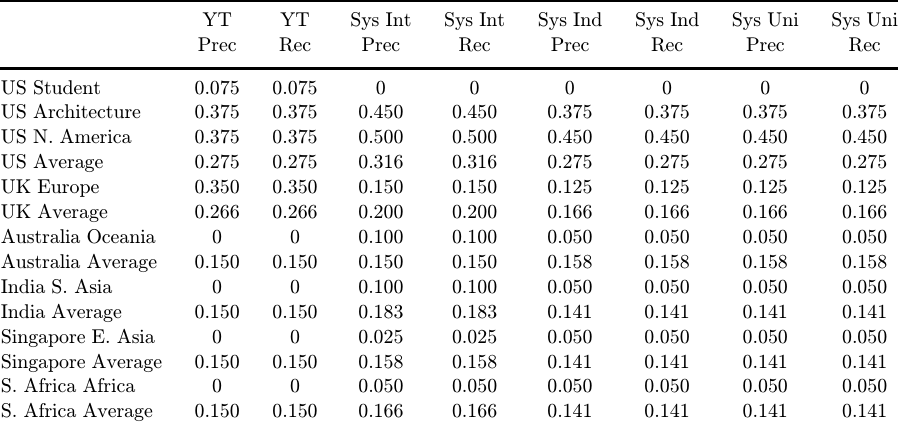
Table 5. Precision and recall scores for YouTube, and for recommendation system under interested, indecisive and uninterested settings in English videos. YT YT US